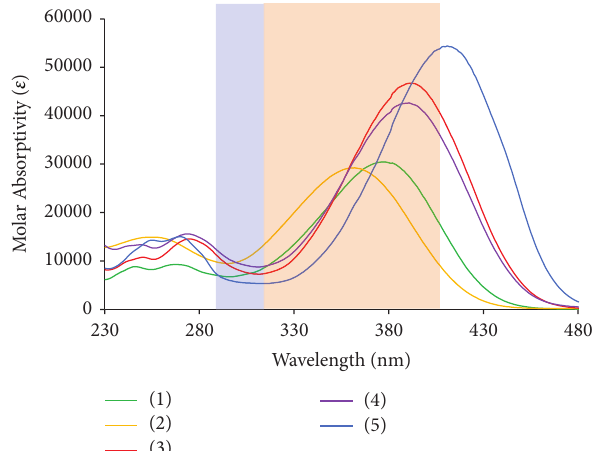
Figure 3: Combined UV-vis spectra for all of the synthesized organic UV filters in 95% ethanol solution, where the blue region represents the UVB range (290–320 nm) and the orange region represents the UVA range (320–400 nm). Table 1: Calculated molar absorptivity ( ε ) in 95% ethanol of p ⟶ π ∗ transition peak for each synthesized sunscreen product. Compound